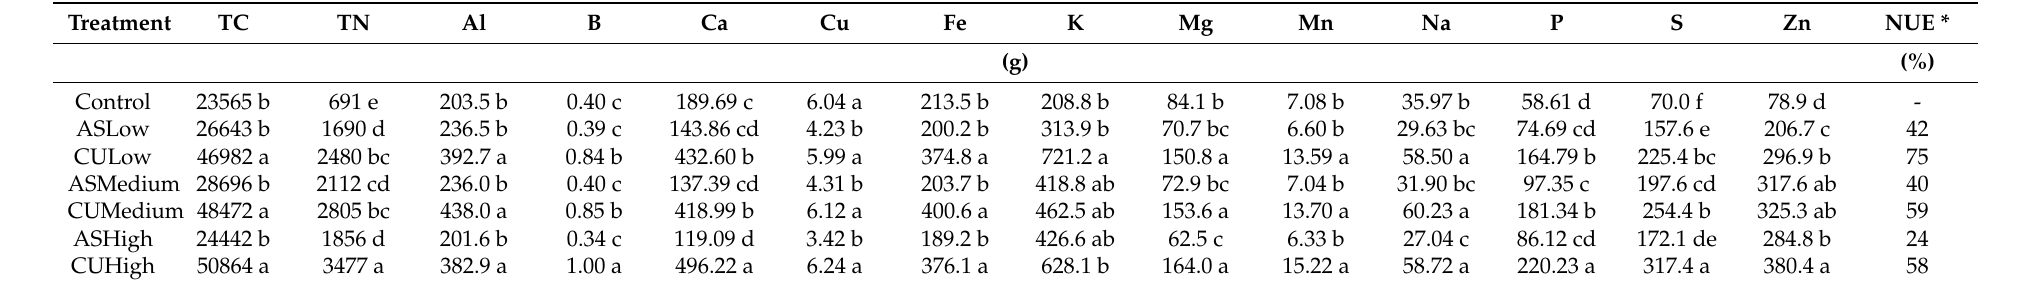
Table 4. Nutrient content in the grass cover (Lolium multiflorum) after the 42-day growing period for each treatment. Parameters designated by the same letter are not significantly different at p <